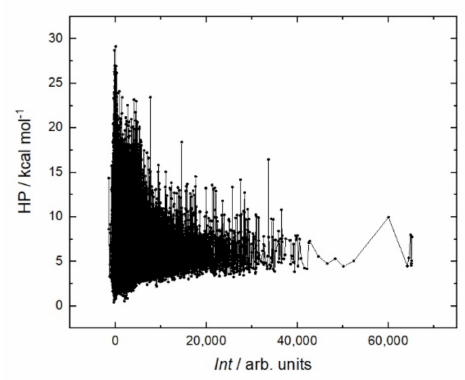
Figure 8. Fluorescent intensity Int of RTX interaction with the resemblance-ranking peptide library versus the sum helix propensity HP of the corresponding peptides [31].